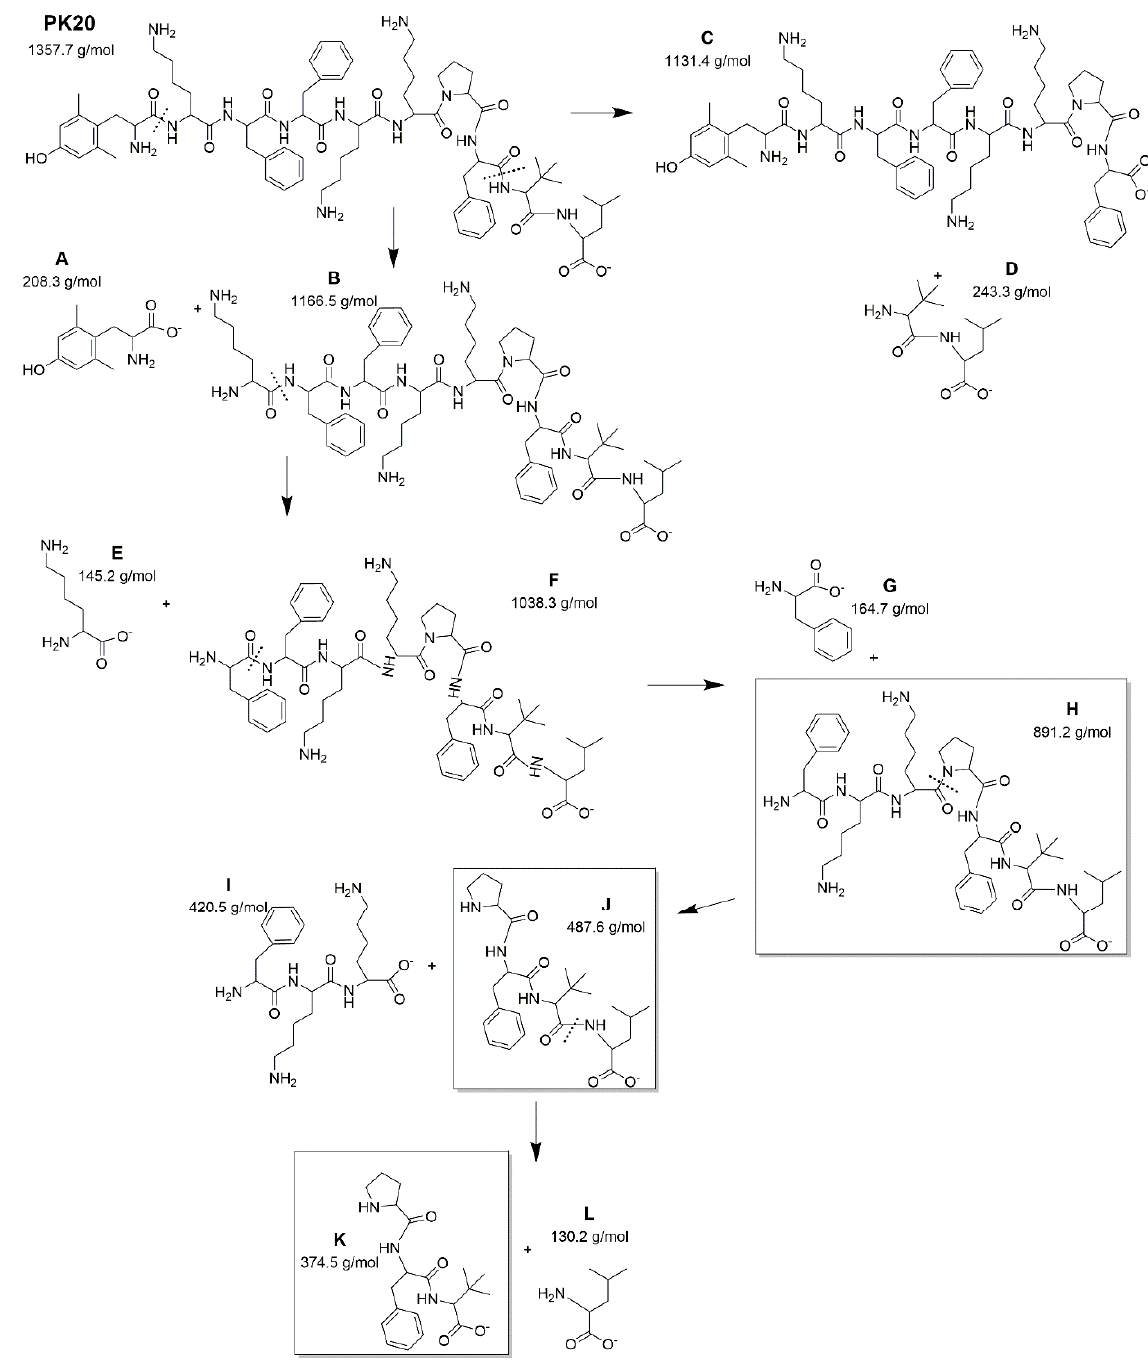
Figure 4. Representative structures of potential PK20 ′ s degradation products based on the molecular weight obtained. Products commonly observed in Figure 2 are given in brackets, and these are as